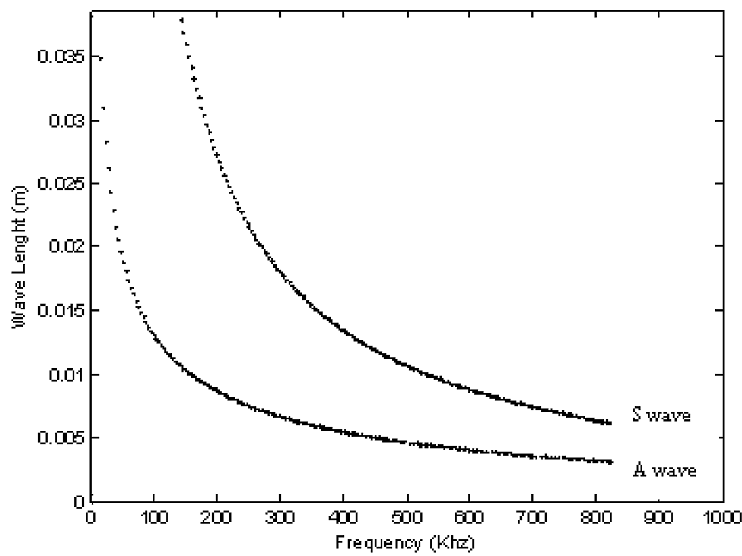
Fig. 5. Lamb waves wavelength vs